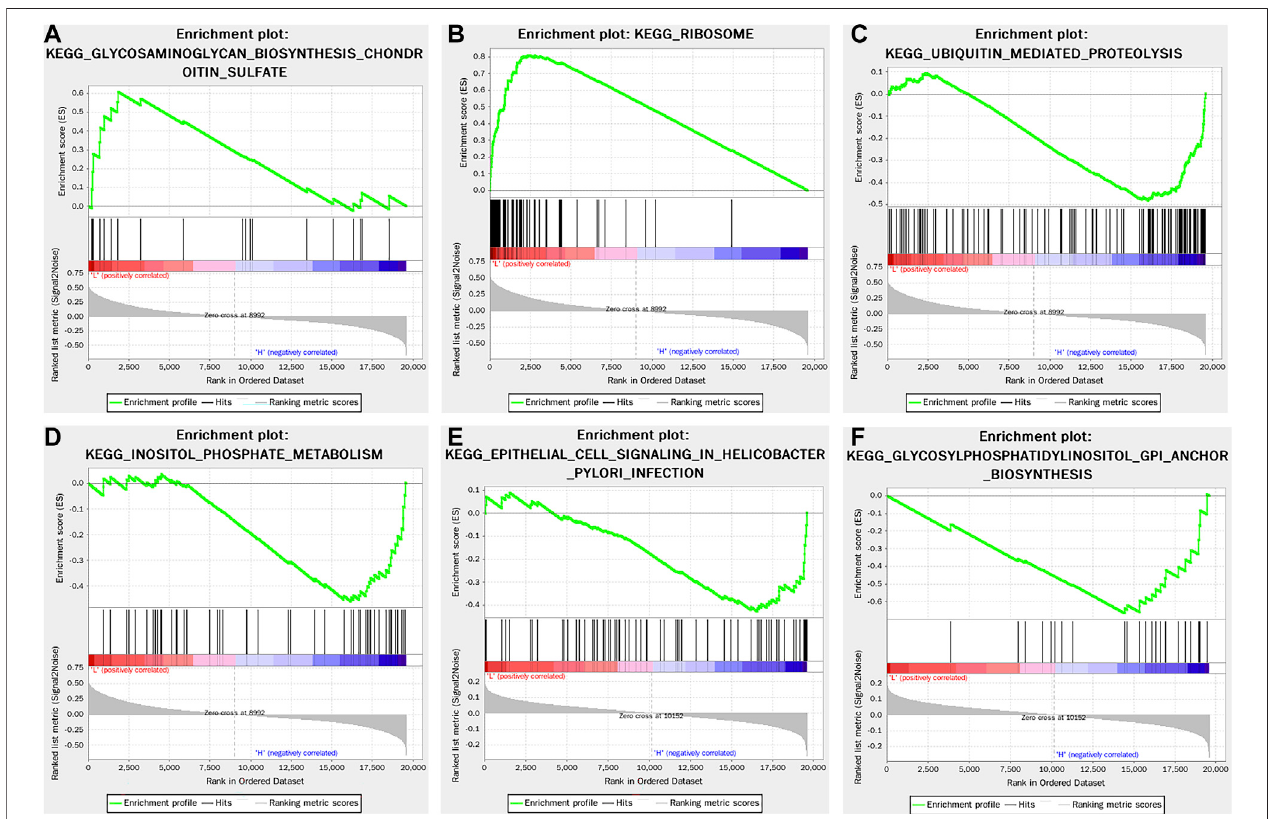
FIGURE 4 | Enrichment plots from GSEA using the single-gene method of YTHDF3. The results showed the four most positively related pathways and two negatively related pathway. (A) Enrichment plot: KEGG_GLYCOSAMINOGLYCAN_BIOSYNTHESIS_CHONDROITIN_SULFATE (B) Enrichment plot: KEGG_RIBOSOME (C) Enrichment plot: KEGG_UBIQUITIN_MEDIATED_ PROTEOLYSIS (D) Enrichment plot: KEGG_INOSITOL_PHOSPHATE_METABOLISM (E) Enrichment plot: KEGG_EPITHELIAL_CELL_SIGNALING_IN_HELICOBACTER_PYLORI_INFECTION (F) Enrichment